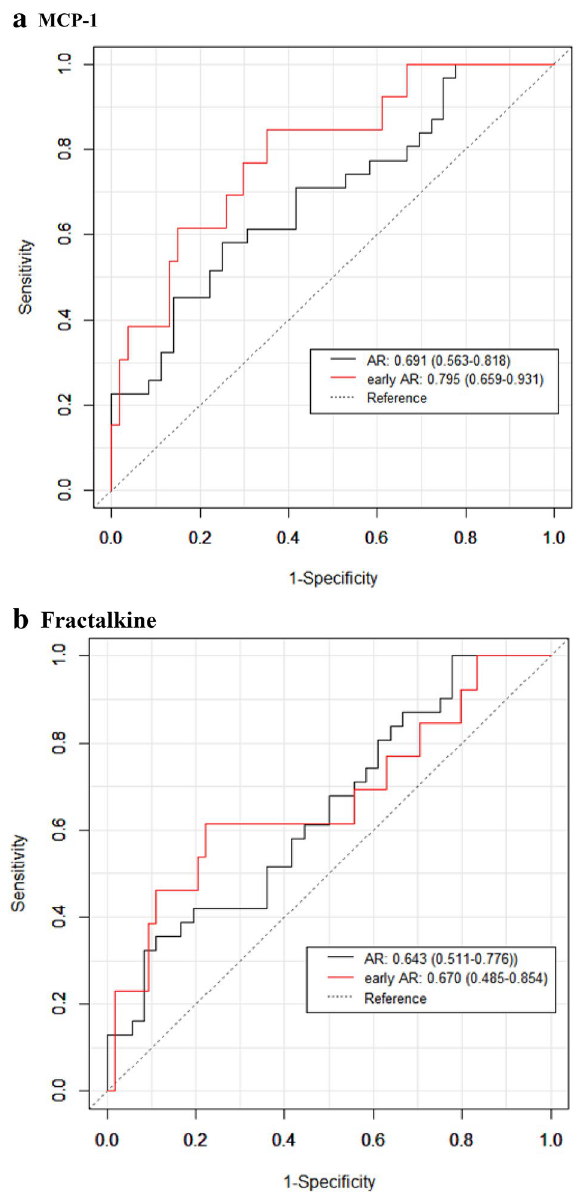
Figure 6. Internal validation of post-KT 1 week urinary MCP-1 and fractalkine. ( a ) AUROC of urinary MCP-1 predicting early AR and AR was 0.795 and 0.691, respectively. ( b ) AUROC of urinary fractalkine predicting early AR and AR was 0.670 and 0.643, respectively. AR acute rejection, AUROC area under the receiver operating characteristic, CI confidence interval, KT kidney transplantation, MCP-1 monocyte chemoattractant